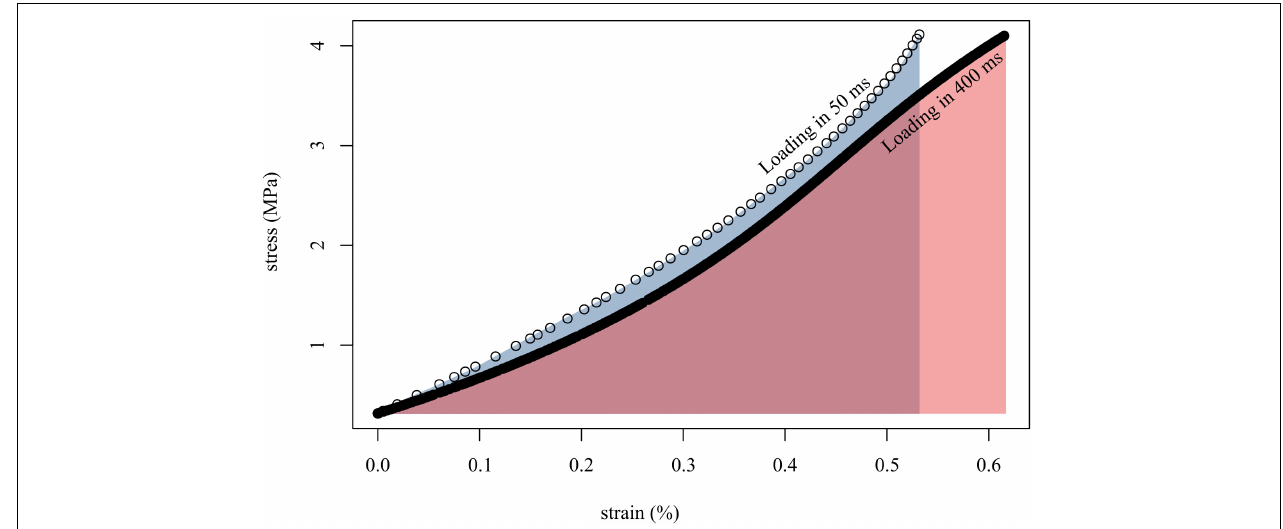
FIGURE 4 | Loading tendon fascicles quickly (in 50 ms; open circles) resulted in higher stiffness (slope of open circles) and lower final strain than when loading the same fascicles slowly (in 400 ms; solid black line) . This translated to more work done on the fascicle when loaded slowly (red area) than when loaded quickly (gray area) . Shown here are representative data from a single tendon